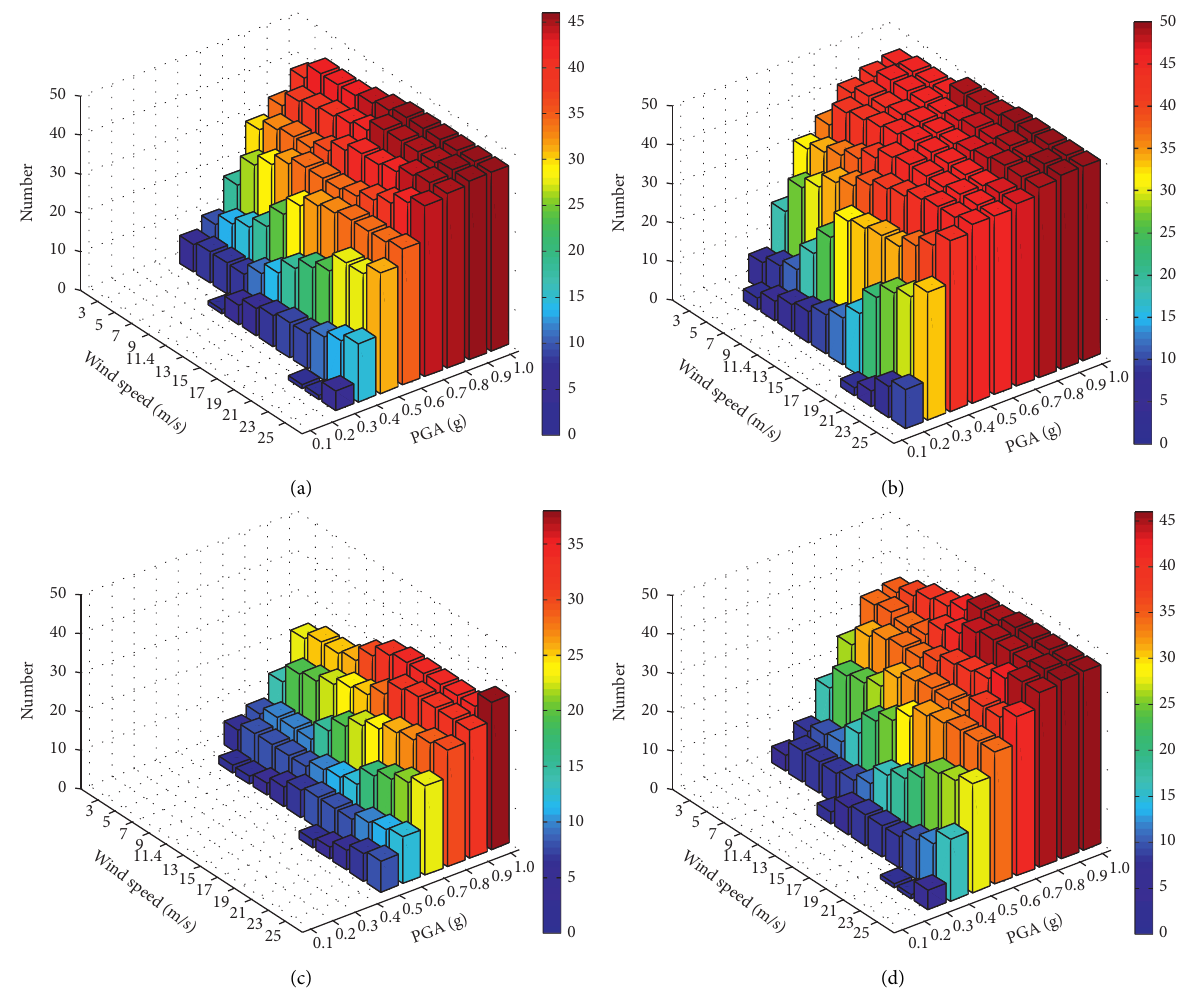
Figure 7: The number of exceeding specified critical levels for different wind speeds and PGA in model 1: (a) MY, (b) ML, (c) DY, and (d) DL.